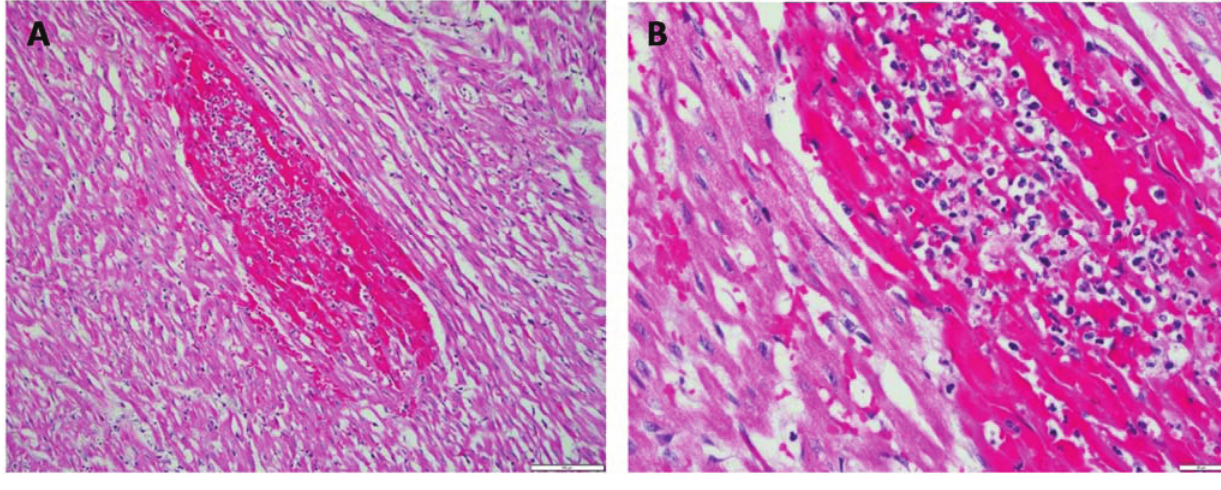
Figure 3. Case 4. Multifocal to coalescing areas of coagulative necrosis within myocardium characterized by the presence of hypereosinophilic and shrunken cardiomyocytes. In addition, there are multifocal hemorrhages that replace and separate the adjacent